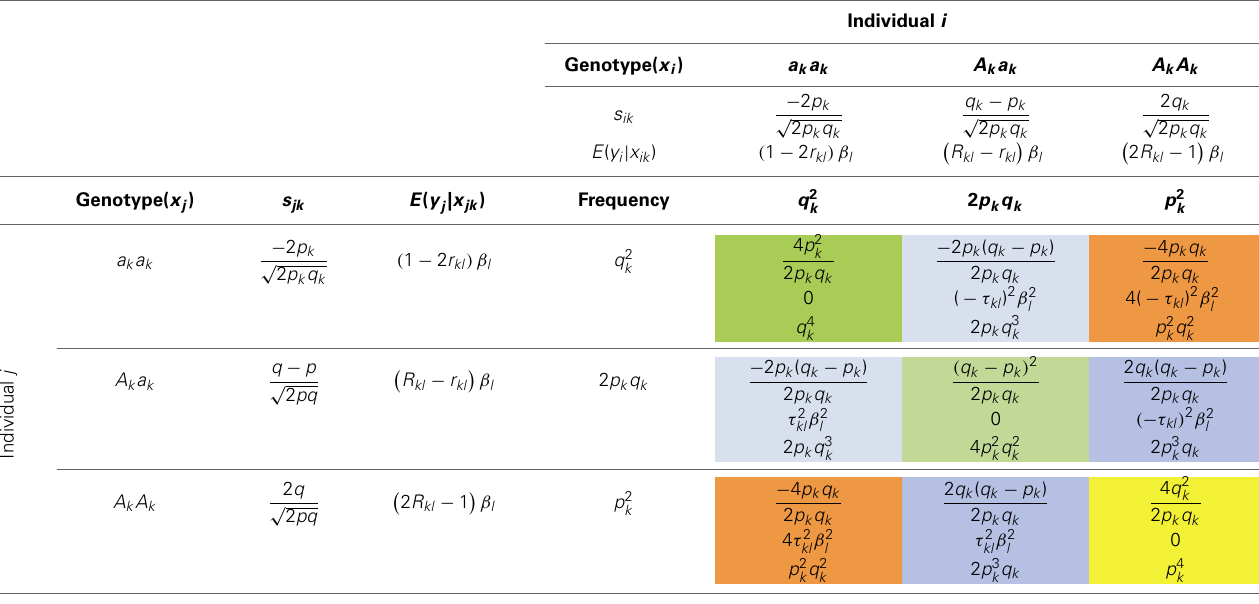
common environment, ance. The negative ratio between the regression coefficient and the intercept provides an estimate of the heritability if the phenotype is not standardized. The derived regression coefficients and their sampling